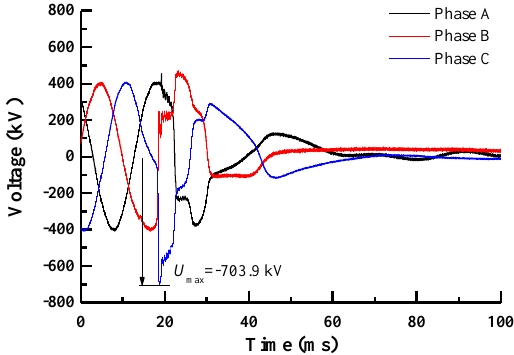
Figure 11. Transient voltage during switching off the #3 power transformer on Batang substation.